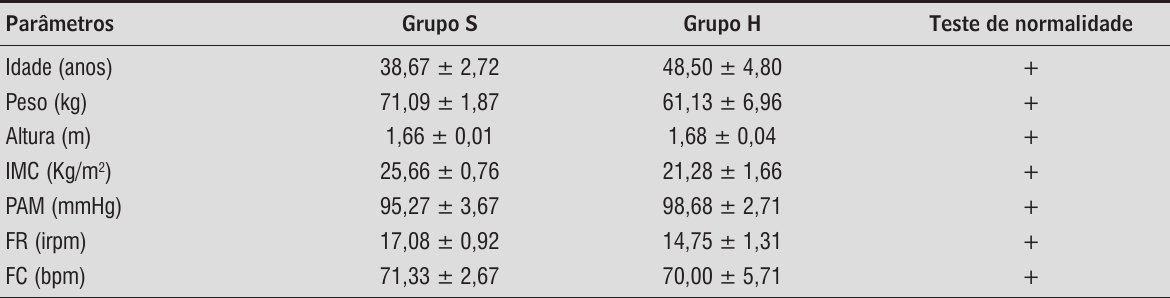
Tabela 1 - Dados antropométricos e variáveis clínicas do grupo de indivíduos saudáveis e do grupo de indivíduos hospita- lizados Parâmetros